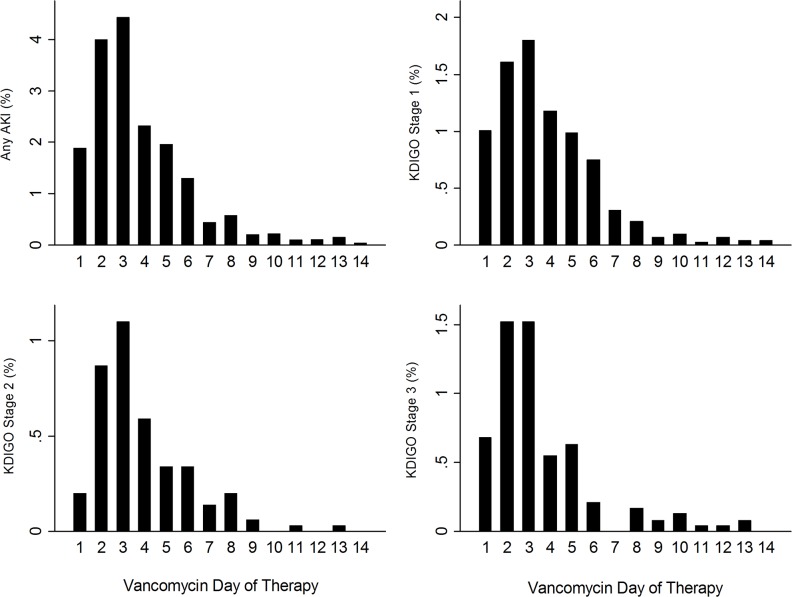
Percent of patients achieving maximum KDIGO status by vancomycin day of therapy.The incidence of AKI occurs primarily around day 3 of vancomycin therapy.